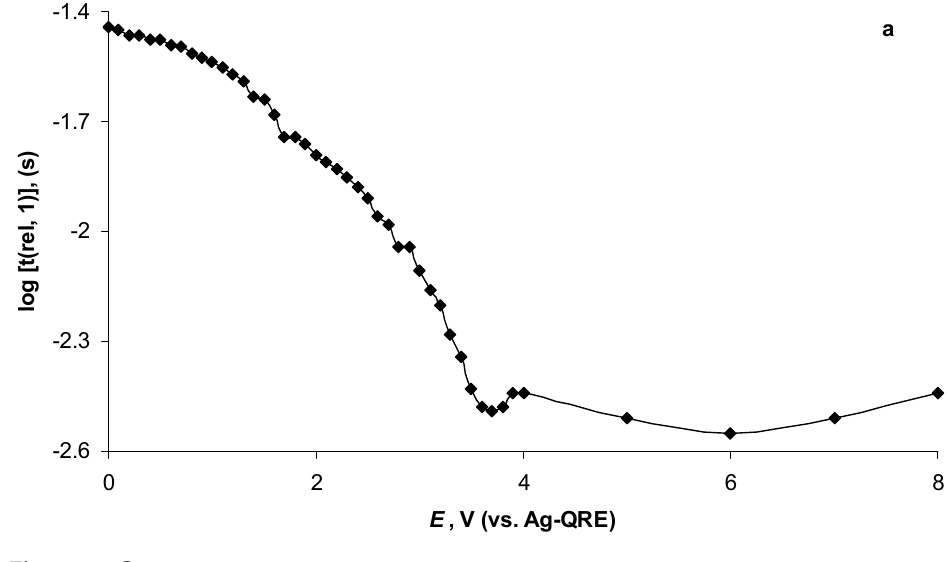
b Figure 11. Cont